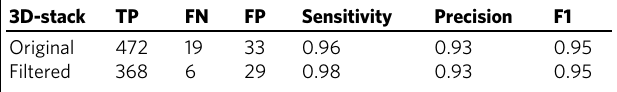
Table 3 Performance of objectwise